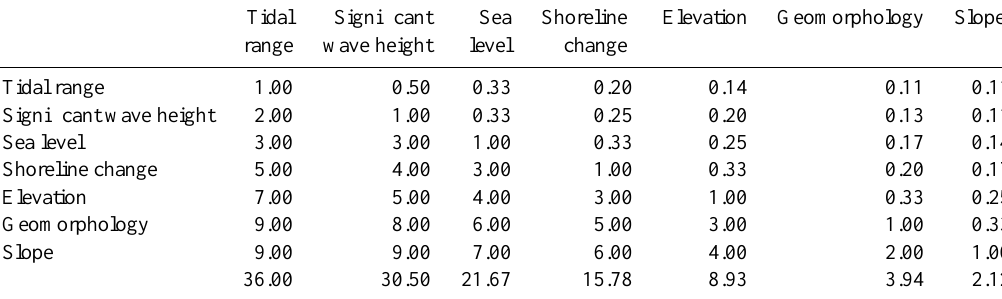
Table 6. Normalized matrix of physical–geological variables. Tidal Significant Sea Shoreline Elevation Geomorphology Slope range wave height level change Tidal range Significant wave